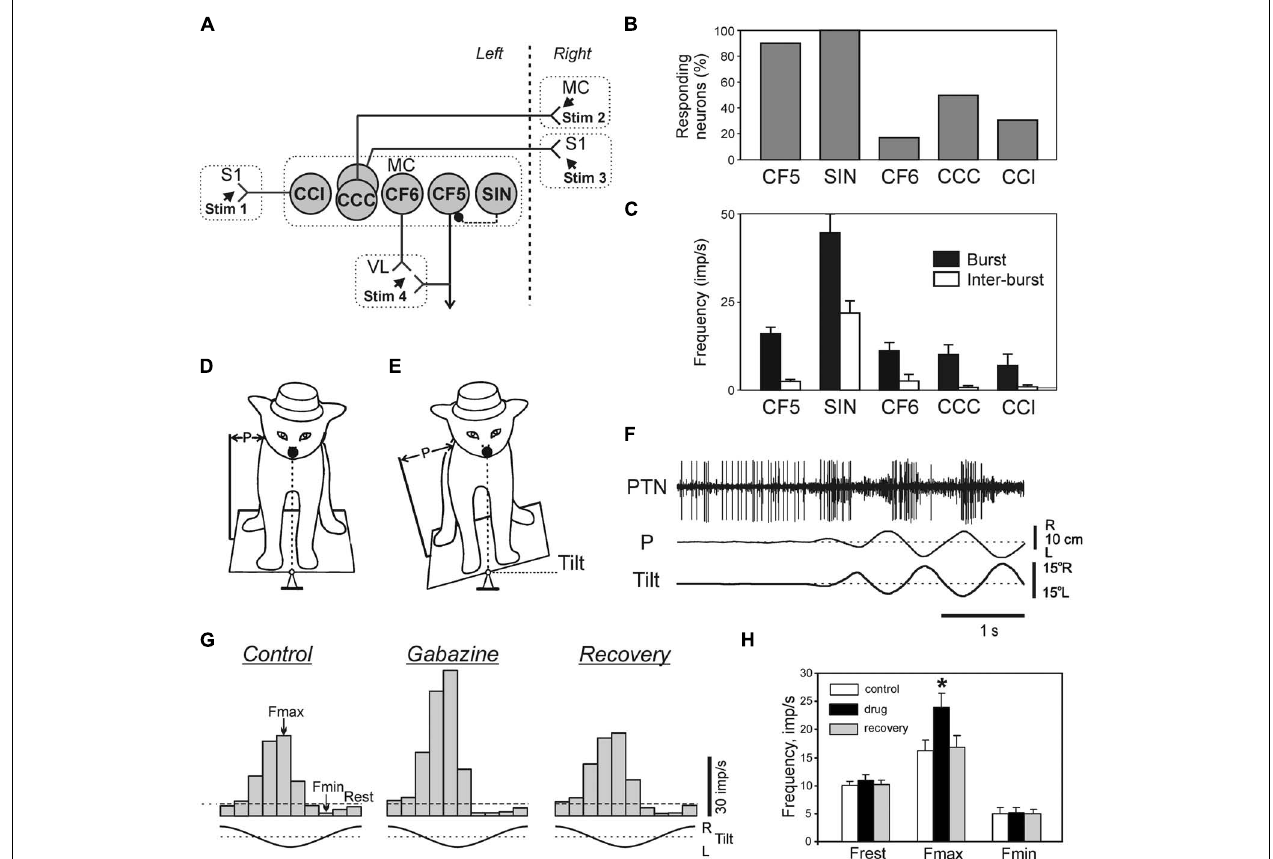
FIGURE 10 |Activity of different classes of neurons in the motor cortex during postural corrections caused by lateral tilts of the platform. (A) Types of neurons which were recorded in the forelimb representation of the left motor cortex (MC) in rabbits. CCI, cortico-cortical neurons projecting to the ipsilateral primary somatosensory cortex (S1); CCC, cortico-cortical neurons projecting to the contralateral motor (MC) or primary somatosensory cortex (S1); CF6, corticofugal neurons of layer VI projecting to the ventrolateral thalamus (VL); CF5, corticofugal neurons of layer V with collaterals projecting to the ventrolateral thalamus (these neuron types were identified by their antidromic responses to electrical stimulation of the corresponding structures, Stim 1–Stim 4); SIN, putative inhibitory interneurons (identified by their high-frequency orthodromic responses to stimulation of ventralateral